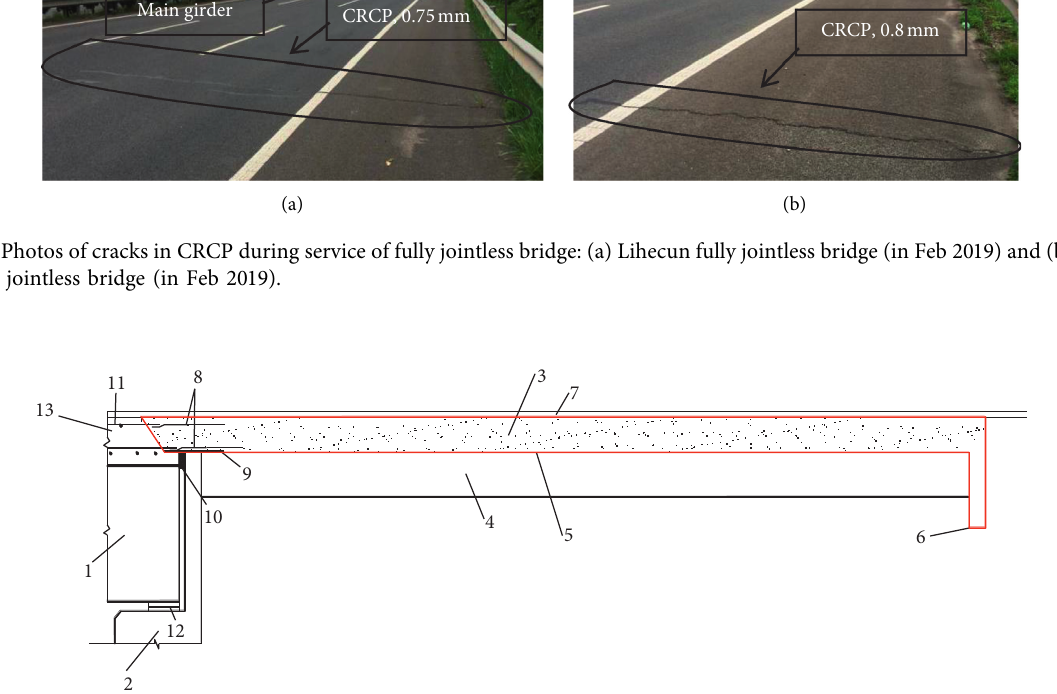
Figure 3: Diagram of the SHCC road-bridge link slab. (1) Main girder; (2) abutment; (3) SHCC slab; (4) concrete base; (5) emulsified asphalt layer (sliding layer); (6) anchor beam; (7) asphalt surface; (8) connect steel bar pavement slab; (9) synthetic pressure pad; (10) self-adhesive compressible sealing materials; (11) reinforcement in beams; (12) bearing; (13) bridge deck.